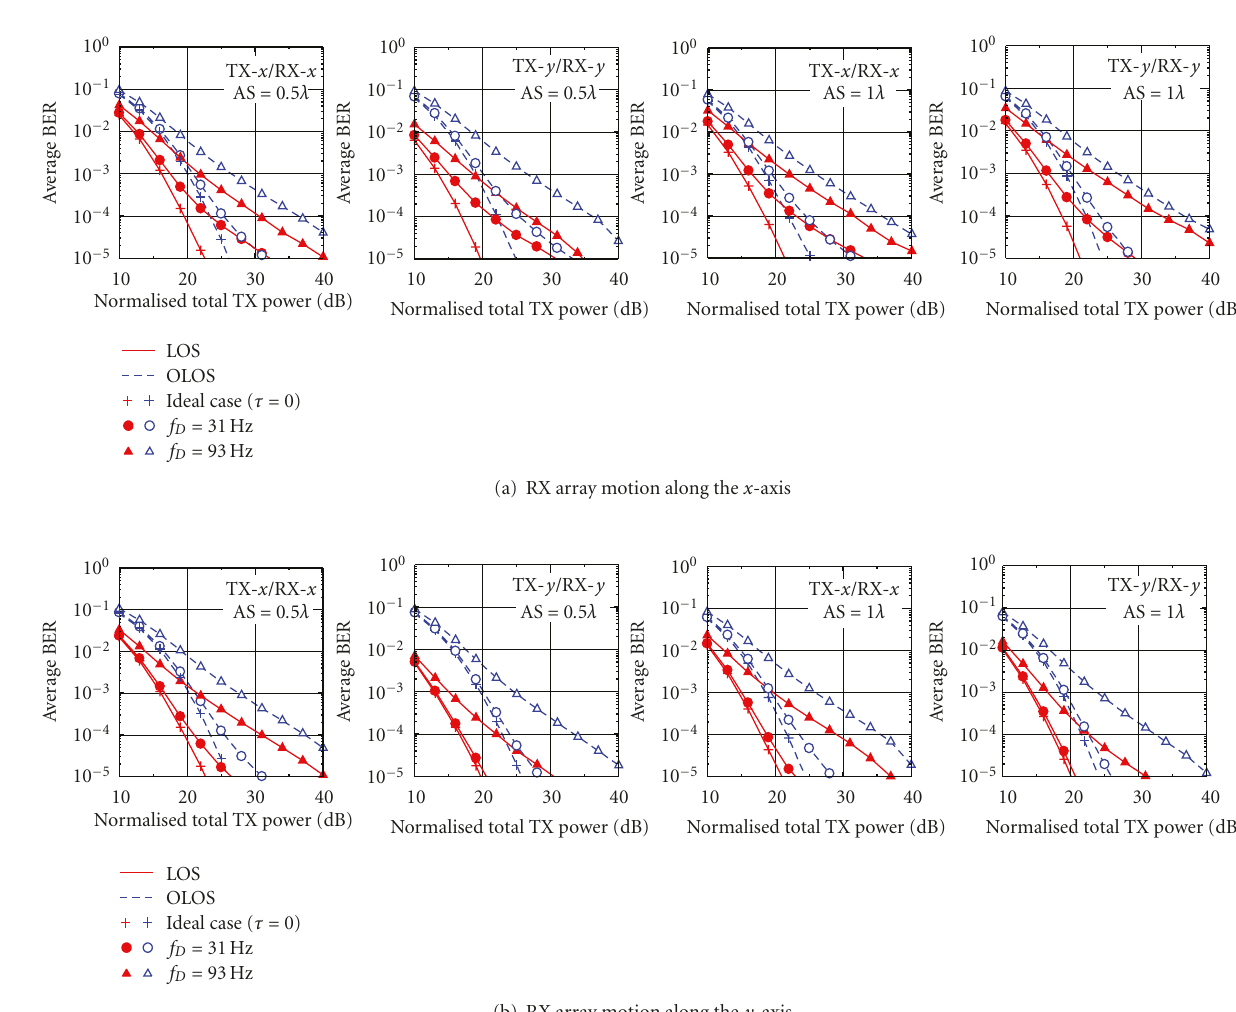
(b) RX array motion along the y -axis Figure 17: BER performance of 2 × 2 MIMO E-SDM